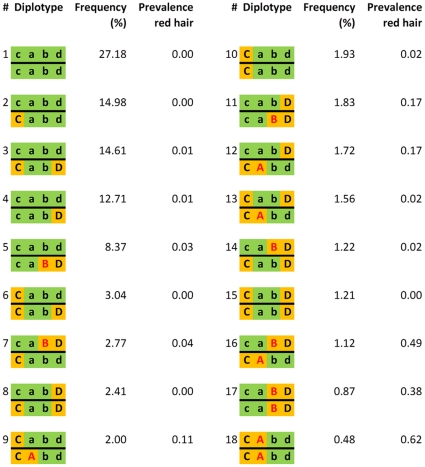
Frequency of diplotypes and the prevalence of red hair in the Rotterdam Study.The causal SNP a is rs1805007 and b is rs1805008. The tagging SNP c is rs2011877 and d is rs2302898. Causal alleles A and B are indicated in red color. Common alleles are indicated in green background and minor alleles are indicated in orange background.